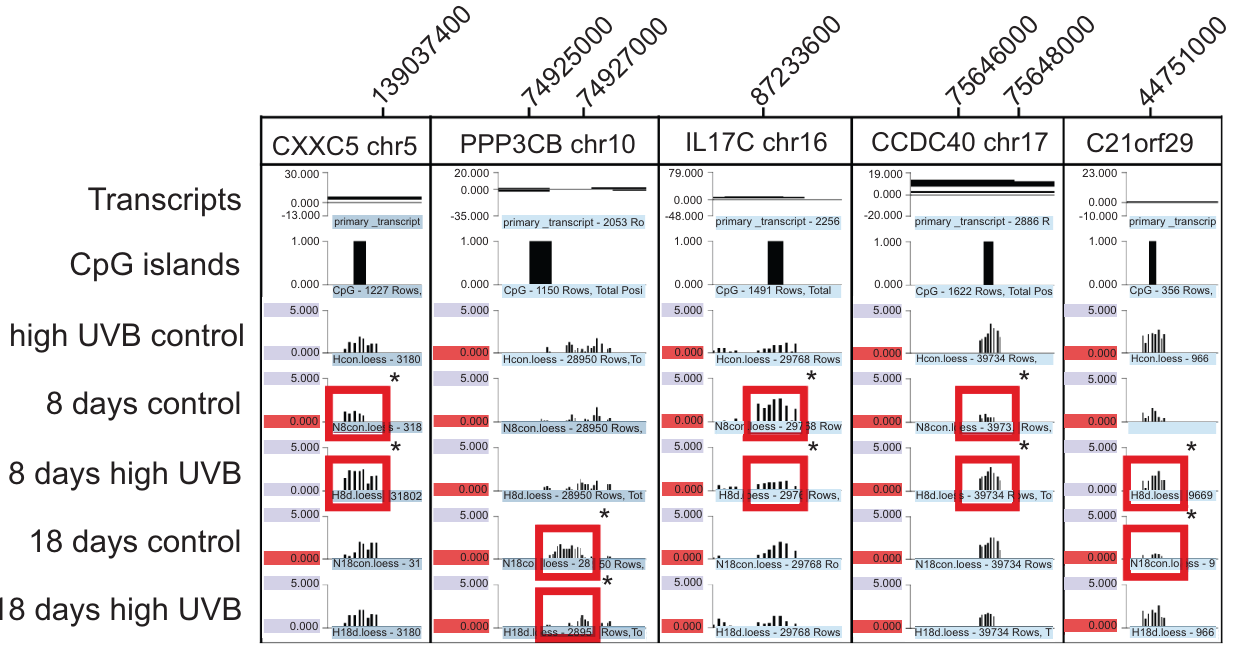
Figure 2. Apparent DNA methylation differences in control and UVB-irradiated keratinocytes. Methylation peaks are shown for the genes CXXC5, PPP3CB, IL17C, CCDC40 , and C21orf29 . The positions of transcripts and CpG islands are indicated. The chromosomal coordinates are shown above each snapshot. The signals framed by the red rectangles are significantly (*) differentially methylated pairs of a control sample and a UVB-treated sample, as determined by bioinformatics analysis. The description of the samples is shown in Figure 1.